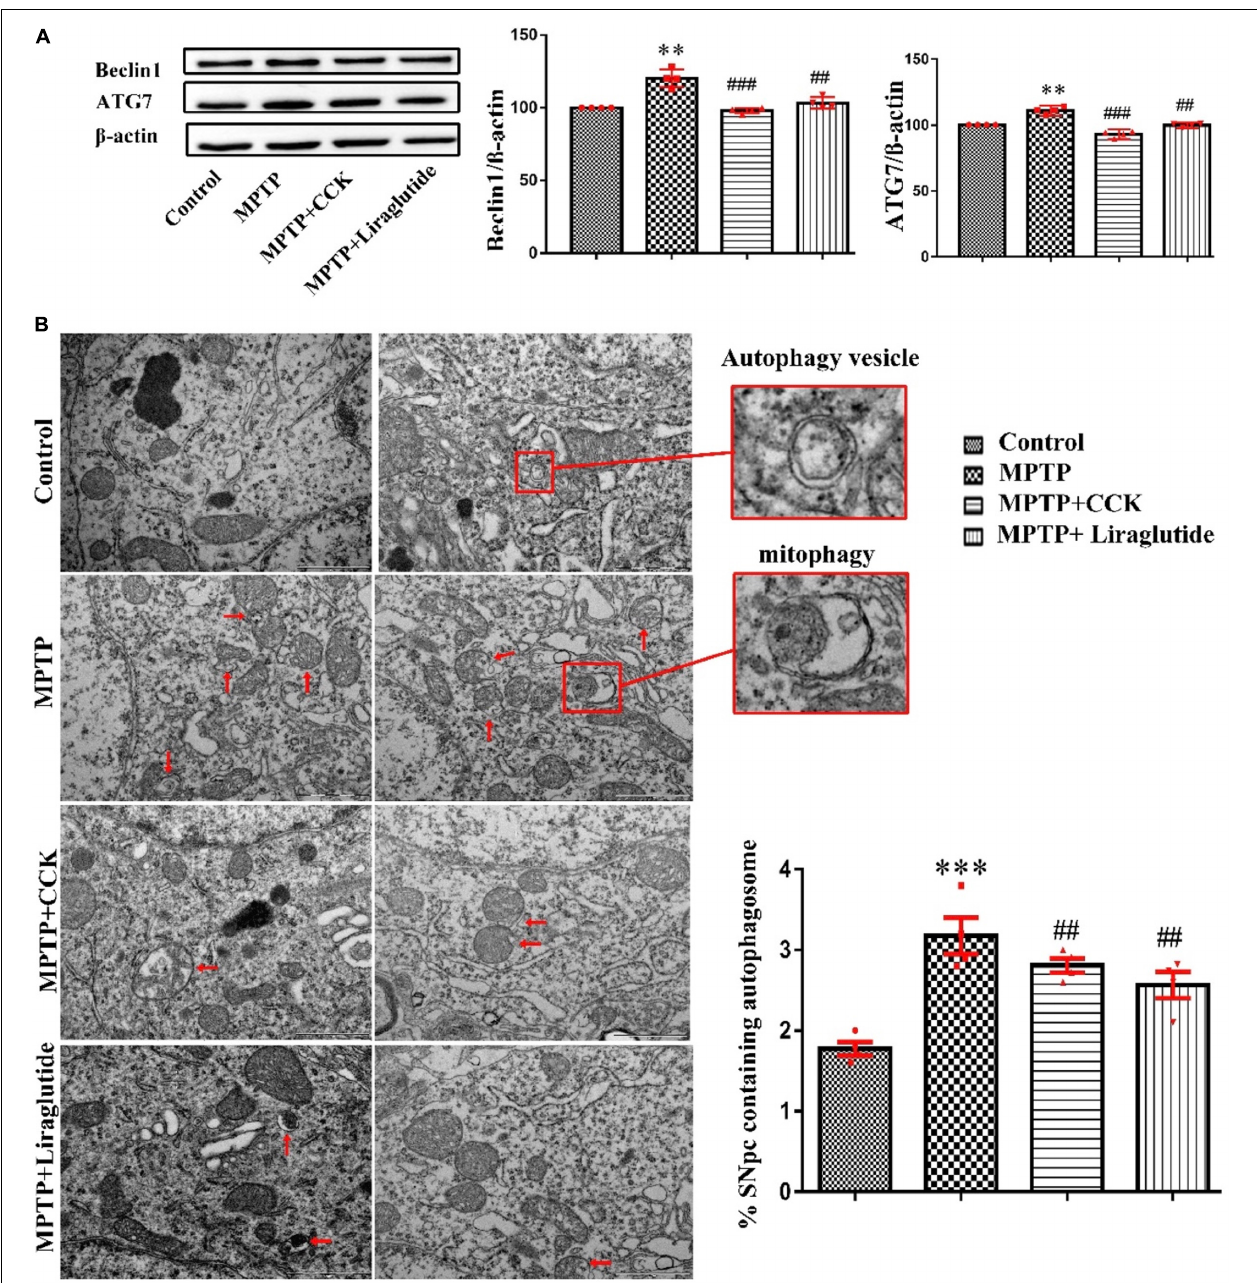
FIGURE 5 | Liraglutide and the CCK analogue regulated autophagy dysfunction induced by MPTP. (A) Western blot showing the protein levels of ATG7, Beclin1 and actin as a loading control for each group. (B) TEM observation of autophagosomes (autophagic vesicles and mitophagy, red arrows) in the SNpc of mice in each group. Autophagy dysfunction induced by MPTP can be alleviated by liraglutide and CCK analogue treatment (Scale bar: 1 µ m). ∗∗ P < 0.01, ∗∗∗ P < 0.001, compared with the control group, ## P < 0.01, ### P < 0.001, compared with the MPTP group, n = 4 per